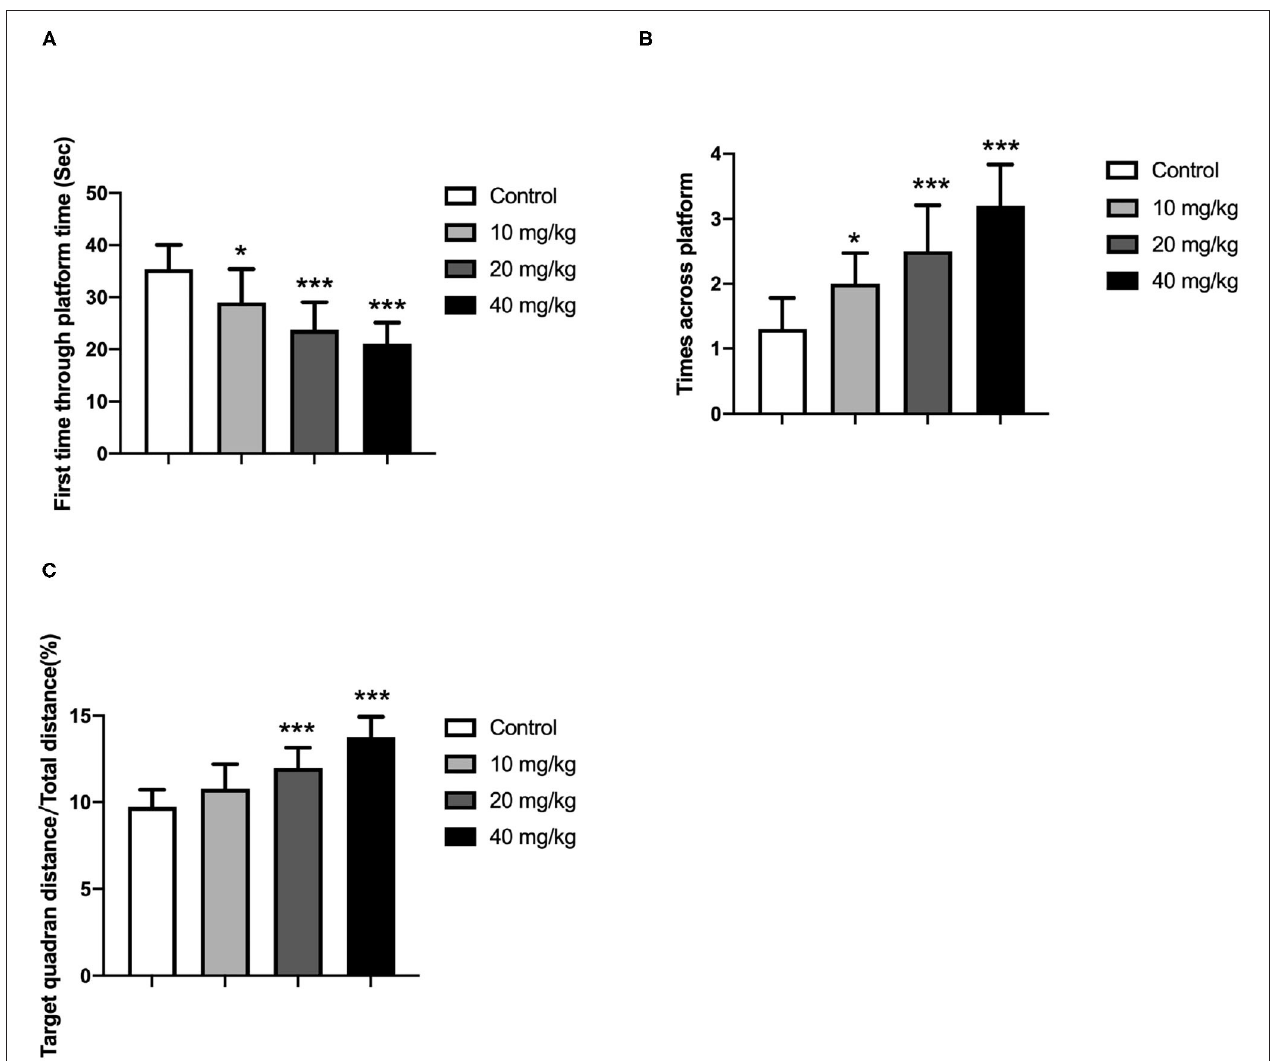
FIGURE 3 | Effects of perinatal Neu5Ac exposure on (A) the time spent in the target quadrant; (B) the across-platform number; and (C) the effective swim distance in the probe test in 100-day-old male rat offspring. Mother rats were treated with Neu5Ac [10, 20, or 40 mg/(kg · day)] or water (as control) from gestational day 15 to postnatal day 21. The results are expressed as the M ± SD ; n = 10 per group. * P < 0.05, *** P < 0.001 indicate a significant difference compared with control-group